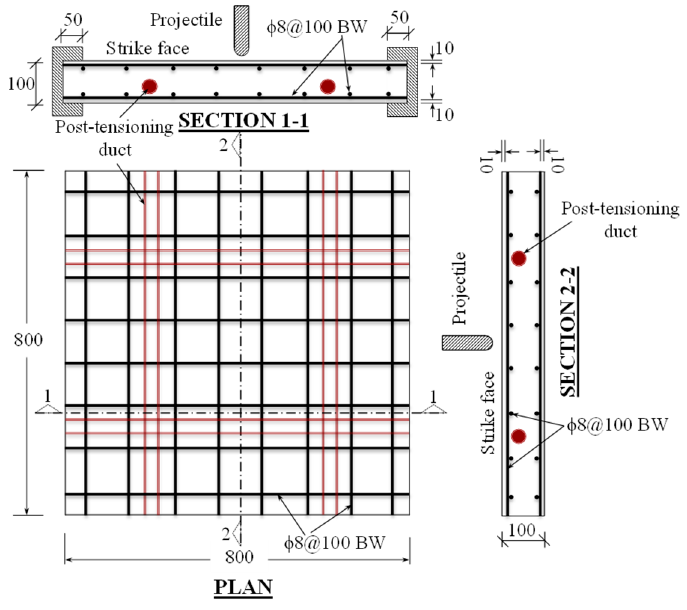
Figure 1. Details of prestressed slab specimens reinforced with rebars (All dimensions are in mm).